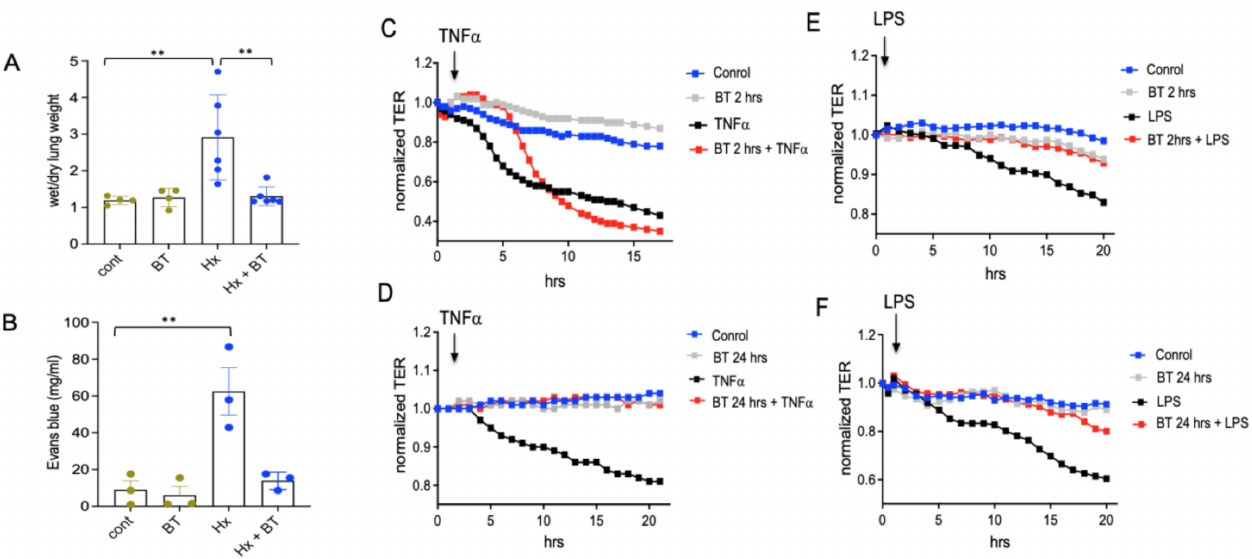
Figure 4. Butyrate exhibits endothelial barrier protective effect in vivo and in vitro. ( A , B ): Evaluation of pulmonary edema and vascular leak. An EBD solution (30 mg/mL) was infused by tail vein injection at a dose of 30 mg/kg for 10 min. Right and left lungs were isolated and processed as described in “Materials and Methods”. Shown are the data of one representative experiment from three; data represent a mean +/ − SED; ** p < 0.01; ( C – F ): Transendothelial electrical resistance (TER) assay in cultured rat microvascular endothelial cells (RMVEC). Cells were grown in ECIS array units (Electric Cell Impedance Sensing System), as described in “Materials and Methods”, pretreated with butyrate for 2 or 24 h, and stimulated with or without TNF α (40 ng/ml) or LPS (1 µ g/ml). Each panel shows one representative experiment from